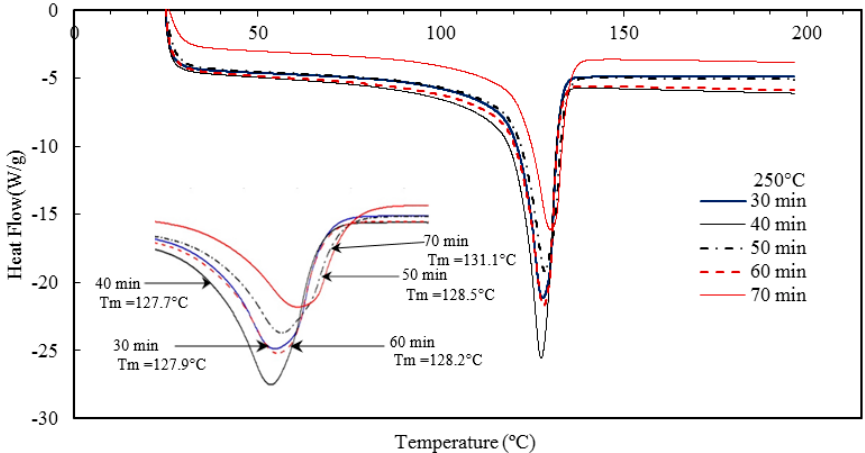
Figure 20. Effect of residence time on the melting temperature of the injection molded nanocomposites.